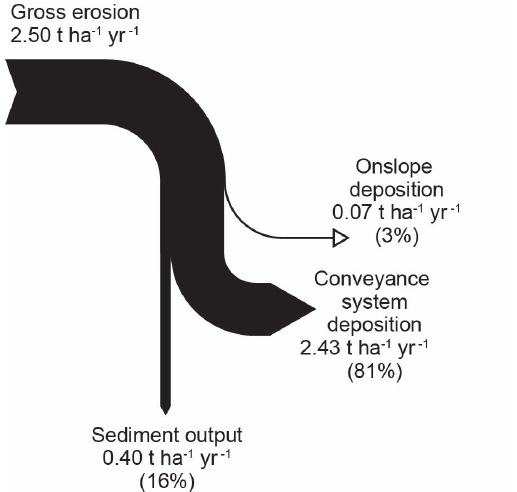
Fig. 5 Schematic sediment budget for the Melito